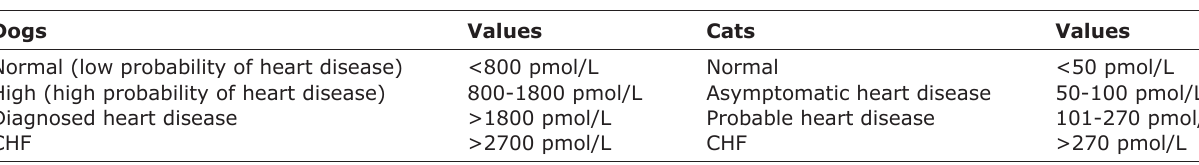
Table-2: NT-proBNP for heart disease in dogs and cats.